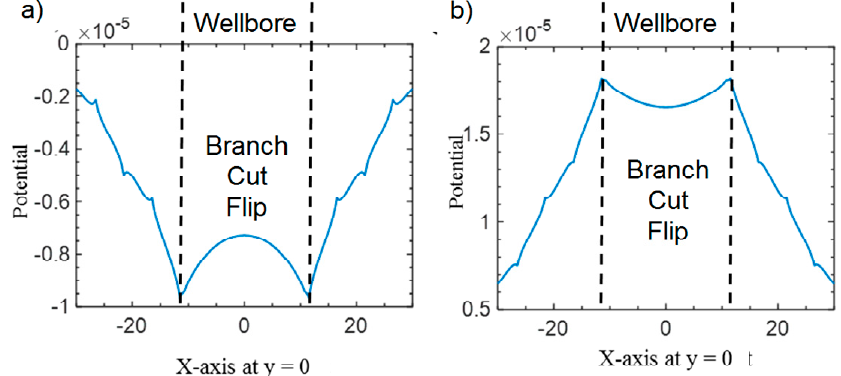
Figure 13. Dynamic bottomhole pressure profiles using the potential function (along vertical axis in cm 2 s − 1 ) for ( a ) underbalanced formation pressure while drilling (Figure 11) and ( b ) overbalanced formation pressure while drilling (Figure 12). Length units are scaled in cm (both x-axis and y-axis).